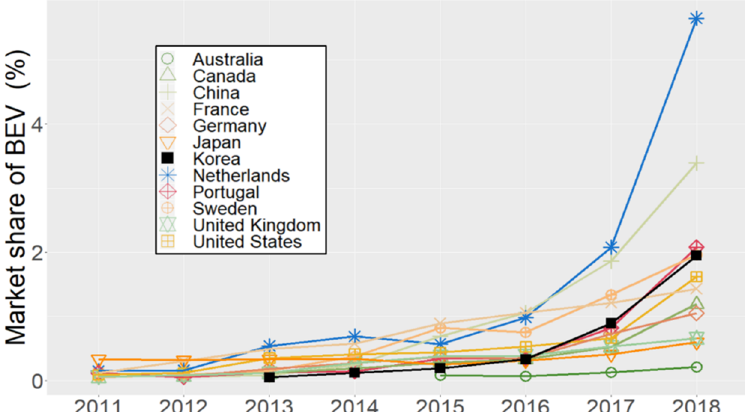
Figure 3. Market share of battery electric vehicles (BEVs) (source: International Energy Agency [14]). Note: Market share means share of new BEV registrations as a percentage of total new passenger car registrations.